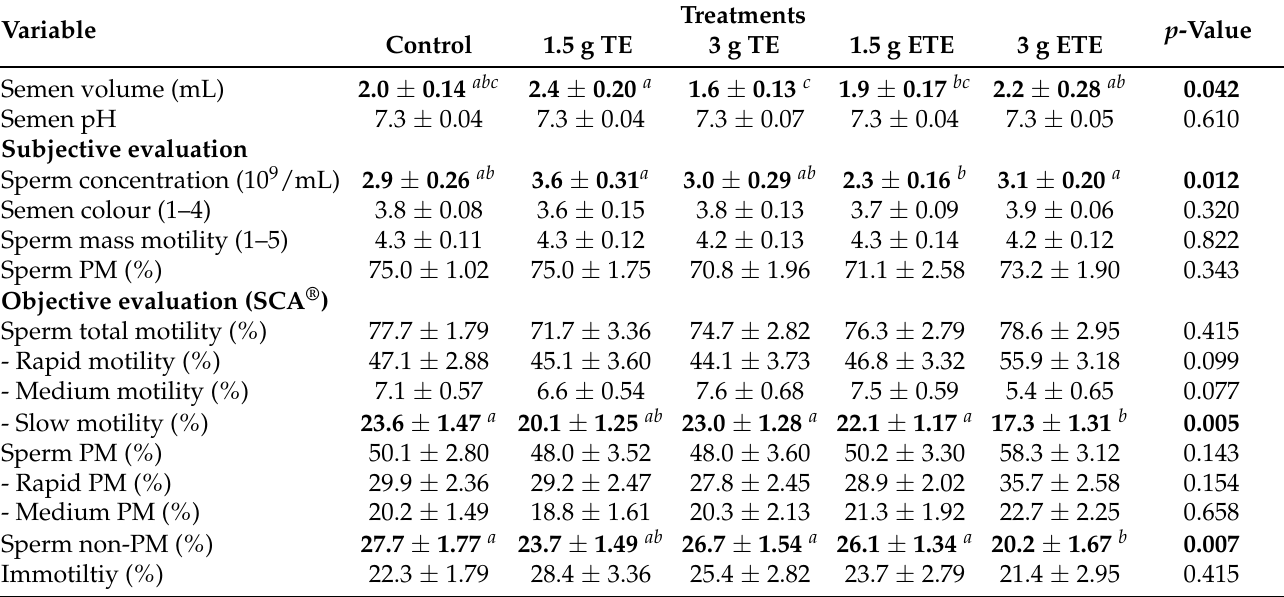
Table 2. The effect of supplementation treatments on the semen quality parameters (Mean ± SE) of South African Mutton Merino